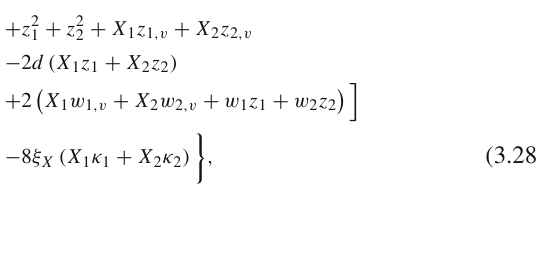
= ξ = 0. The remaining parameters were a m 2 = 0 . 25, α ξ X h = λ = 0 . 1 and X hX